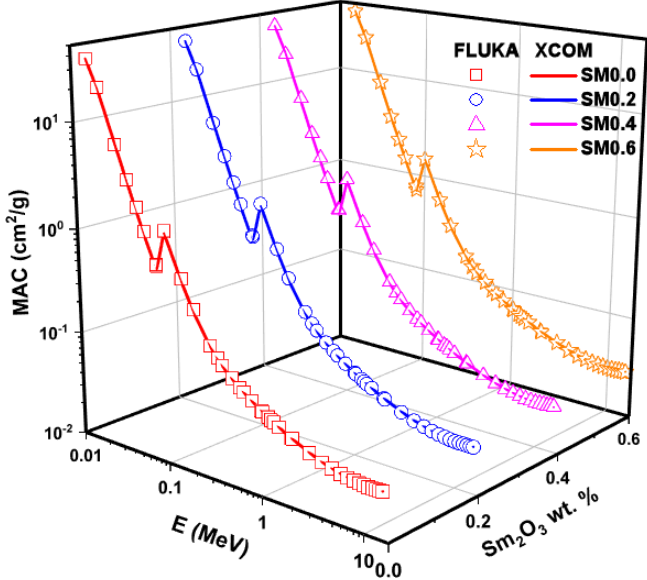
Figure 10. Mass attenuation coefficient by FLUKA and XCOM as a function of glass wt.% and photon energy.